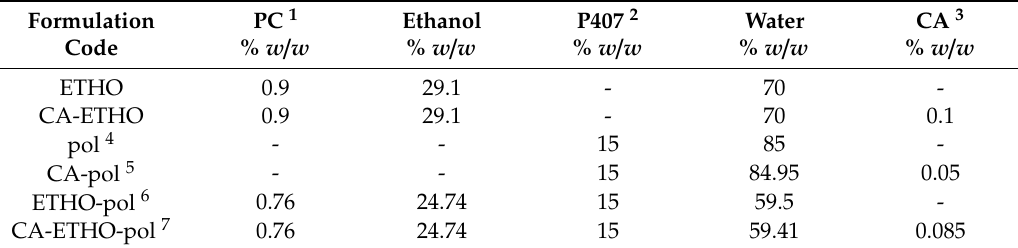
Table 1. Composition of the indicated